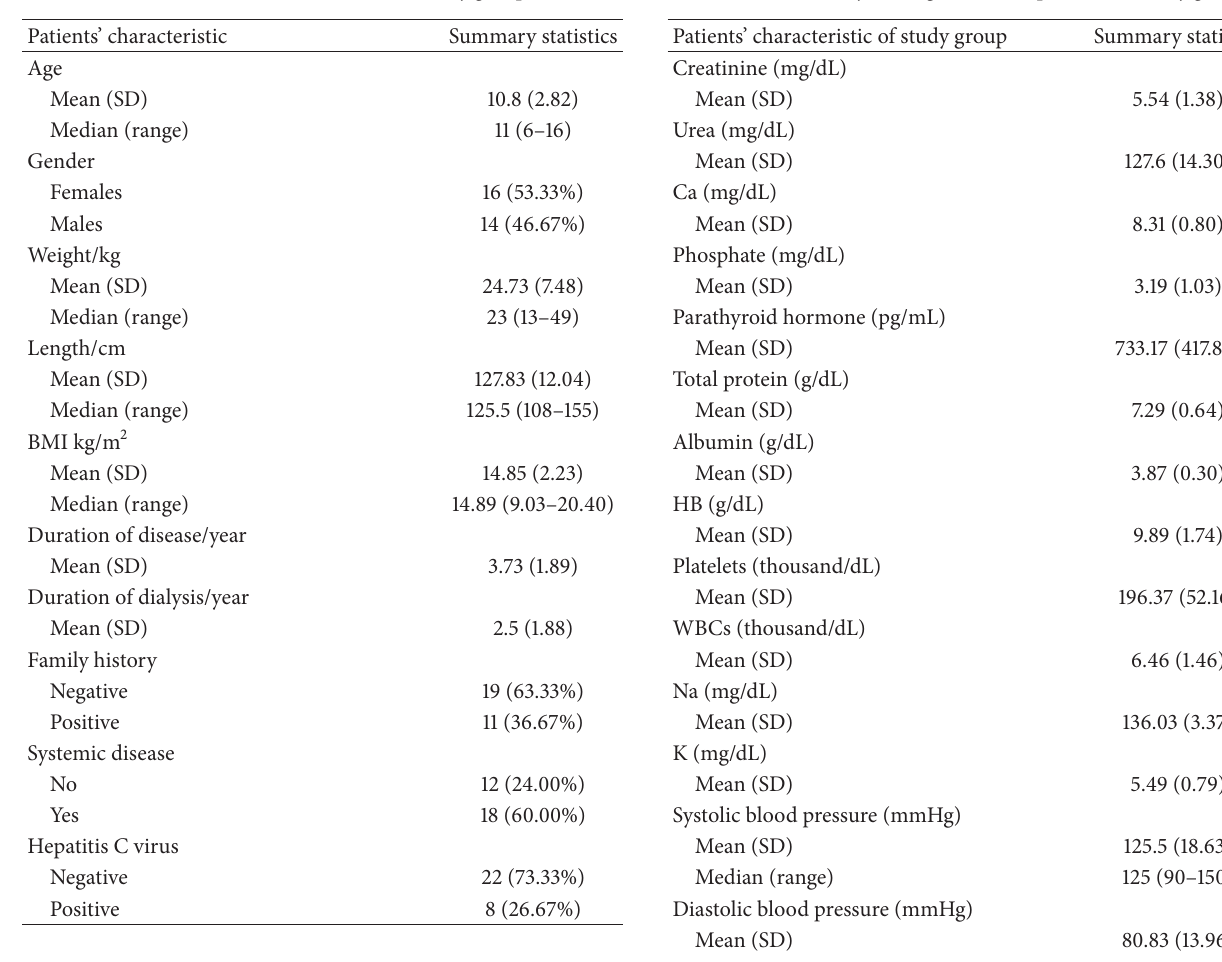
Table 1: Patients’ characteristic of study group. Table 2: Laboratory finding and blood pressure of study